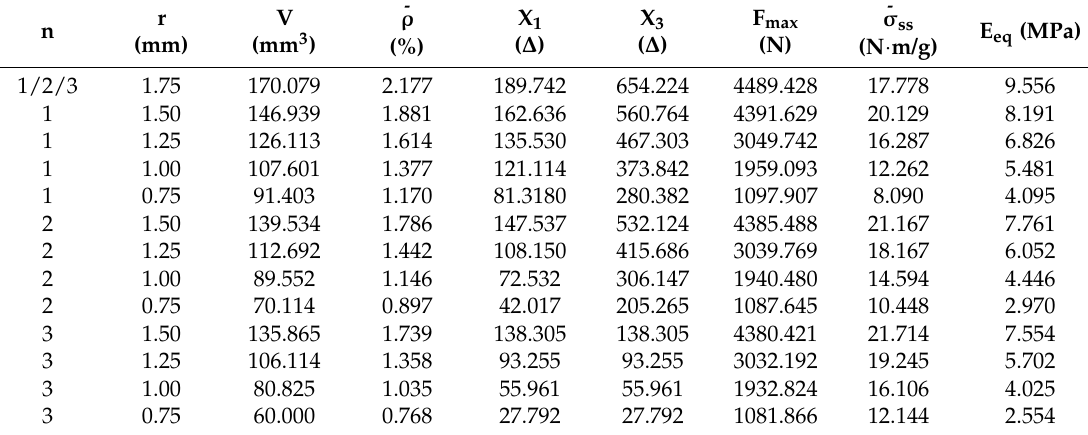
Table 5. The theoretical load capacity, the specific strength, and the equivalent compressive elastic